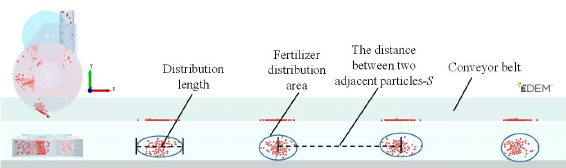
Fig. 4. Schematic diagram of fertilizer particles distribution performance based on